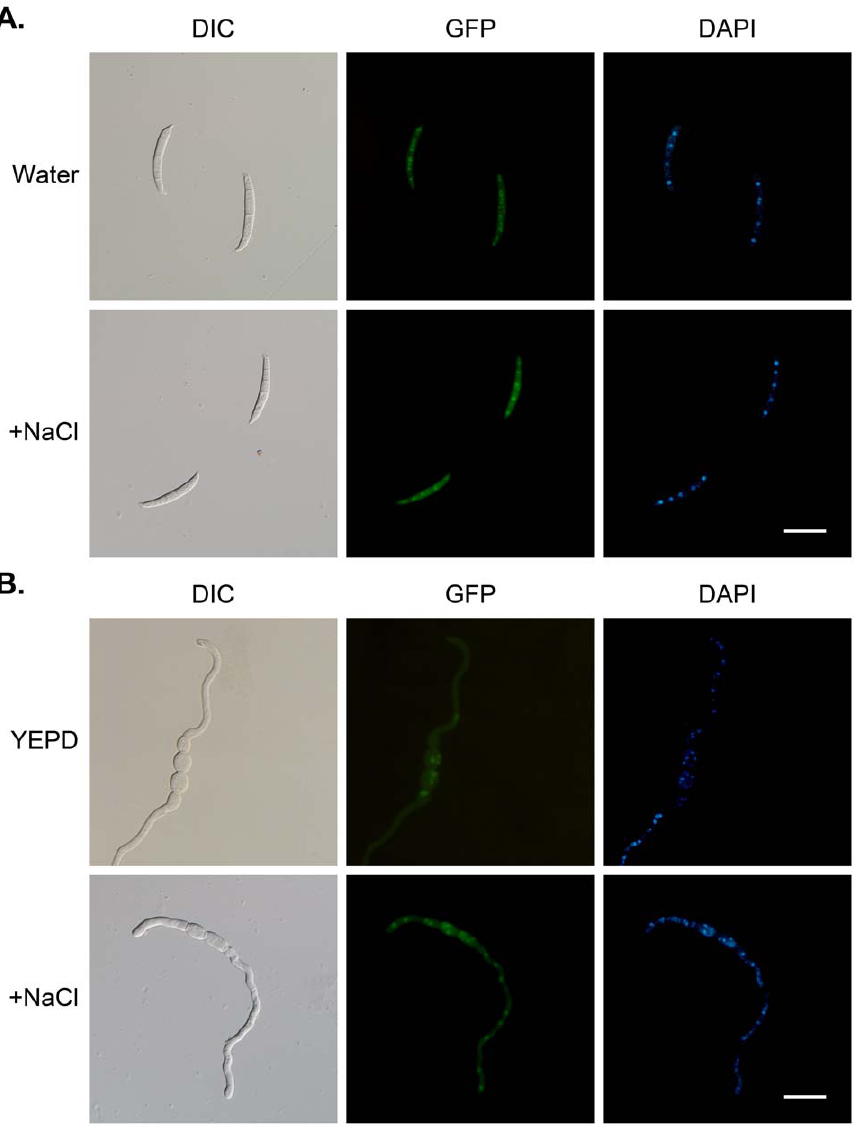
Figure 7. Expression and subcellular localization of FgHog1-GFP. A. Conidia harvested from the Fghog1 / FgHOG1 -GFP transformant HGC1 were re-suspended in sterile distilled water or 0.3 M NaCl and examined by DIC or epifluorescence microscopy (GFP). B. GFP signals in germlings of FGC1 were incubated in the liquid YEPD medium with or without 0.3M NaCl. Nuclei were stained with DAPI. Bar=20 m m.